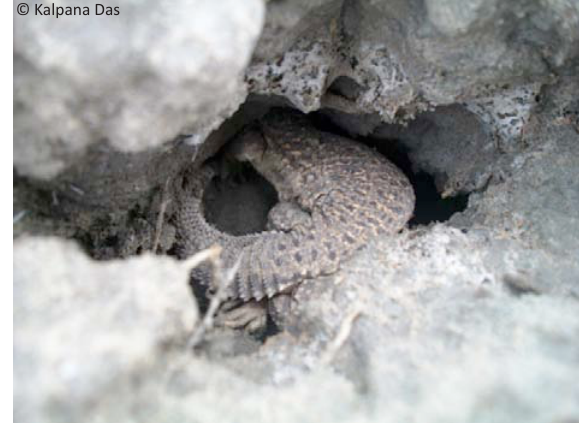
Image 11. Dead Spiny-tailed Lizard in flooded burrow